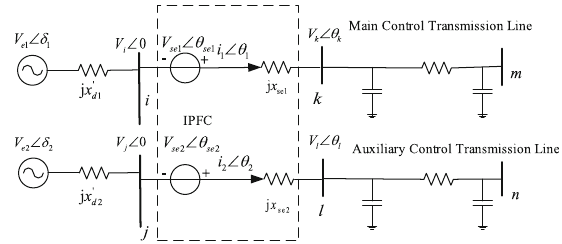
Fig. 2 Single-machine infinite-bus system with IPFC